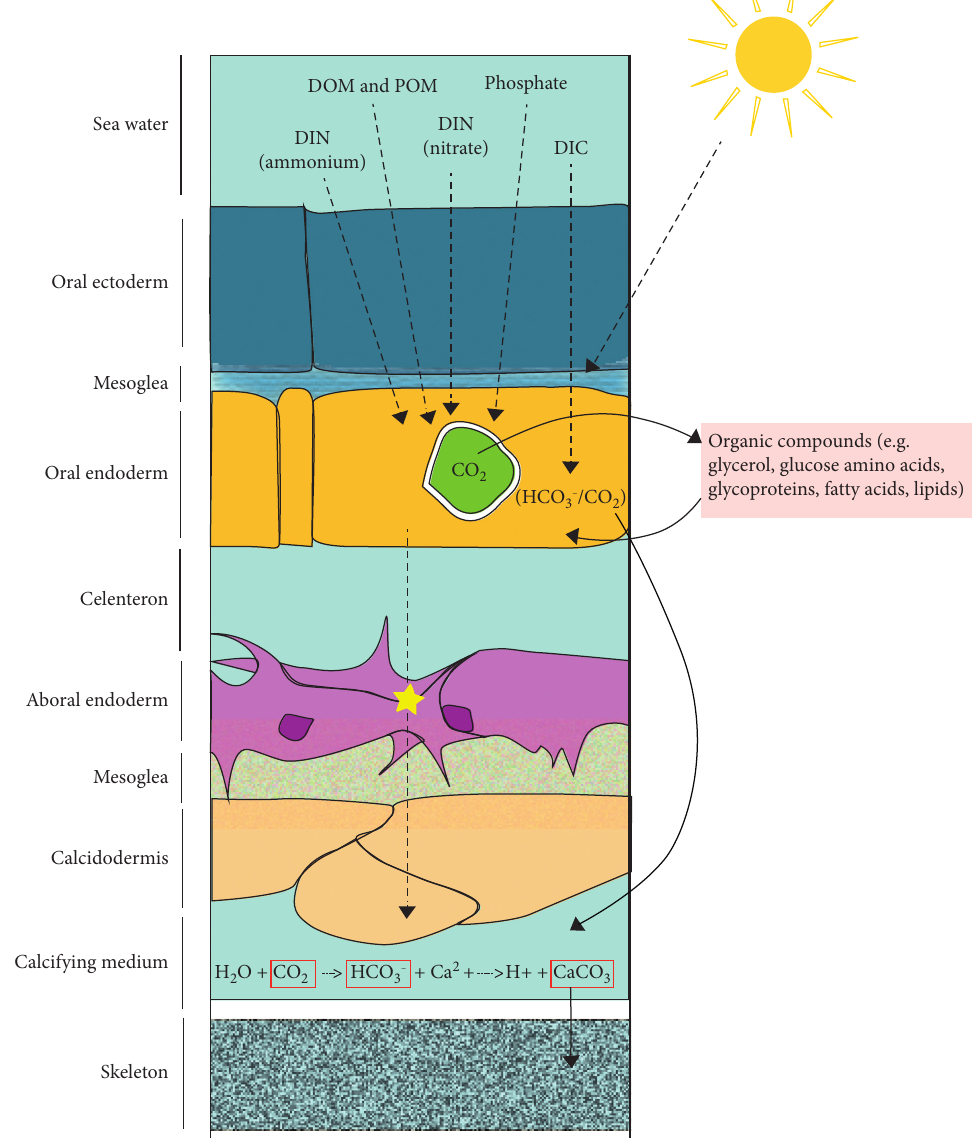
Figure 1: Metabolic interactions and calcification processes. DIC: dissolved inorganic carbon uptake; DOM: dissolved organic matter; POM: particulate organic matter; DIN: dissolved inorganic